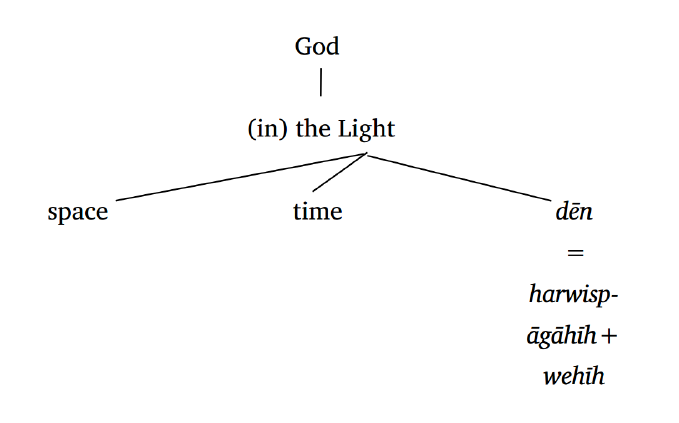
Figure 2 Concept of God according to Bd